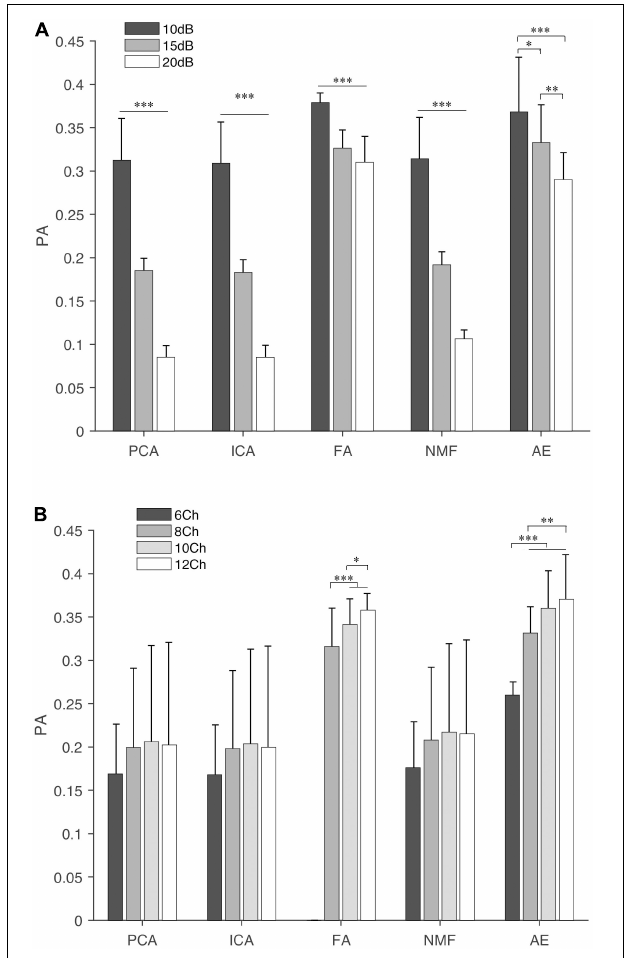
FIGURE 6 | Activation coefficient similarity of extraction methods under different settings, (A) SNR and (B) NoC. The fine line on the bar is the standard error between trials. “ ∗ ”, “ ∗∗ ”, and “ ∗∗∗ ” indicate the significance levels are below 0.05, 0.01, and 0.001, respectively.